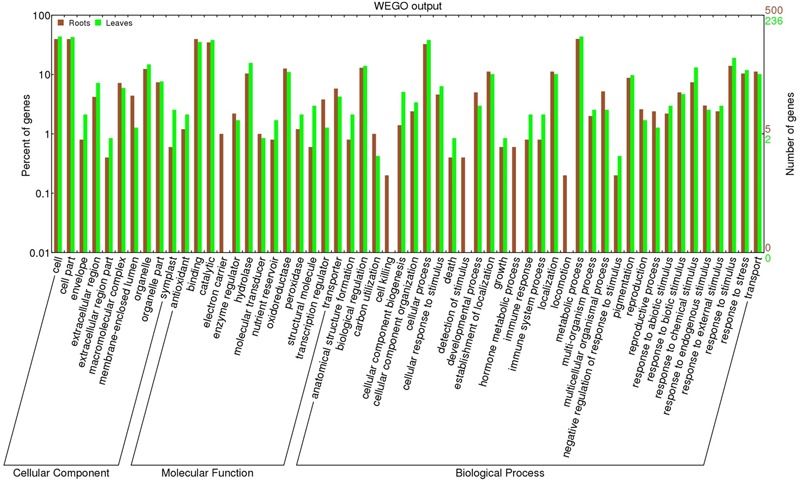
Histogram of GO terms assigned to DEGs in roots (GF677 rootstock, n = 500) and leaves (graft, var. Catherina, n = 236). The DEGs are categorized into three main groups: cellular components (CCs), molecular functions (MFs), and biological processes (BPs). Note that the vertical axes use a logarithmic scale.